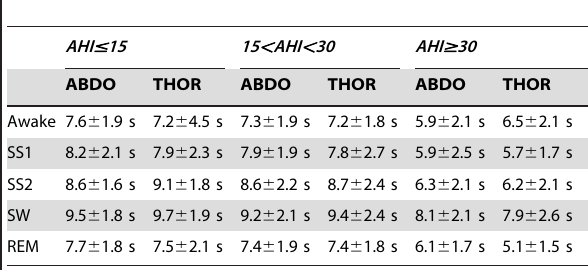
Table 6. Duration of coordinated epochs for different AHI groups and sleep stages using abdominal (ABDO) and thoracic (THOR)